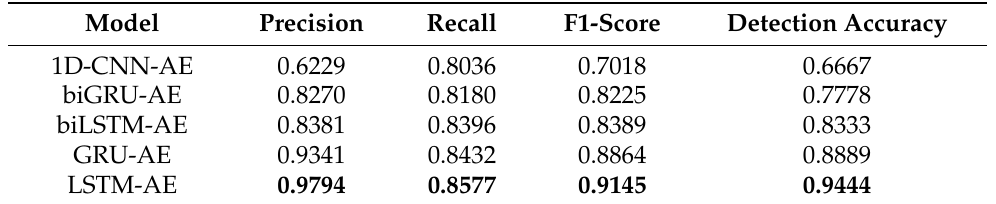
Table 1. Precision, recall, F1-score, and detection accuracy of our proposed model and other autoencoder-based